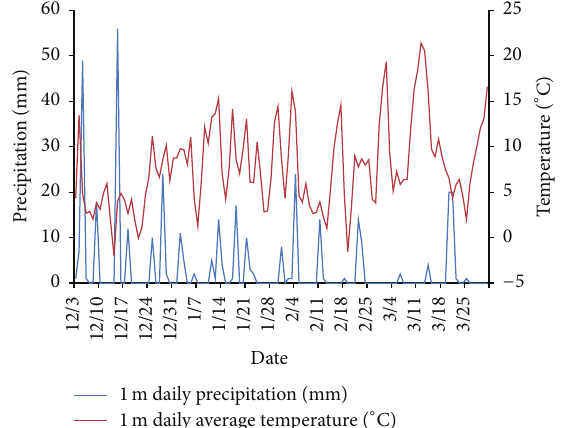
Figure 9: Average daily precipitation and temperature values recorded at the Lake Wheeler Field Laboratory near Raleigh, NC, during year 2.